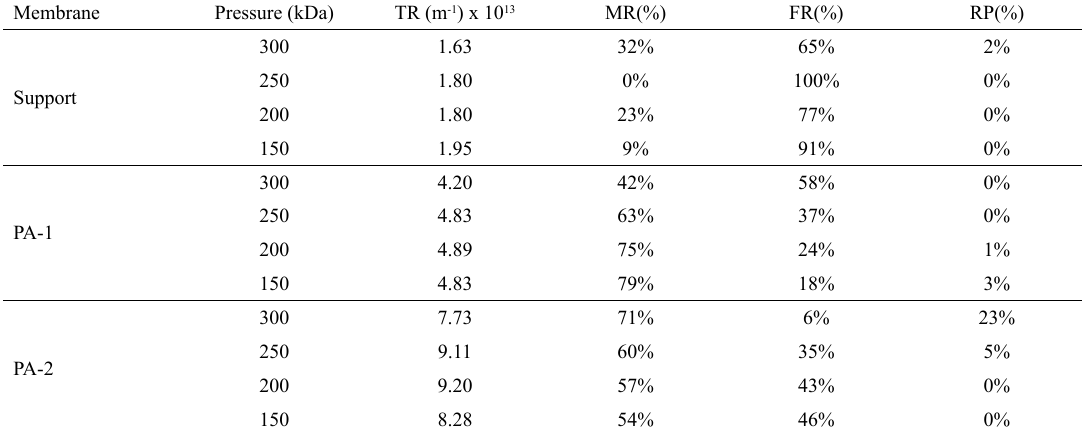
Table 4. Percentage contribution of each type of obstruction with oil concentration of 200 mg∙L -1 . Membrane Pressure (kDa)